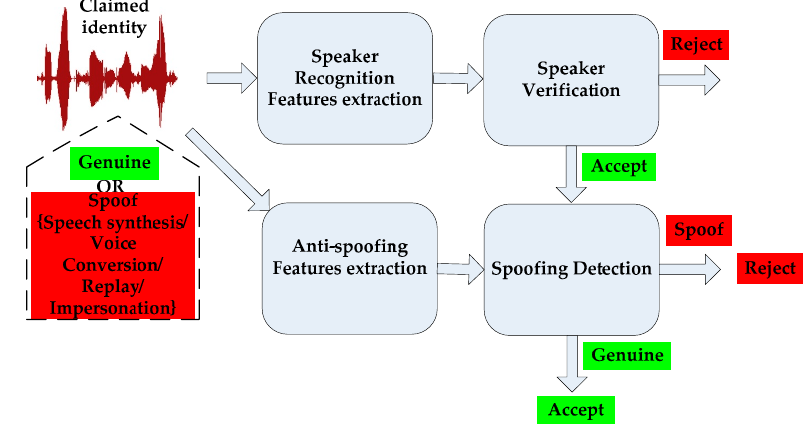
Figure 1. Spoofing detection system incorporated with an automatic speaker verification framework. The speech signal from the claimed identity is passed through the spoofing detection system only when it is accepted by the speaker verification